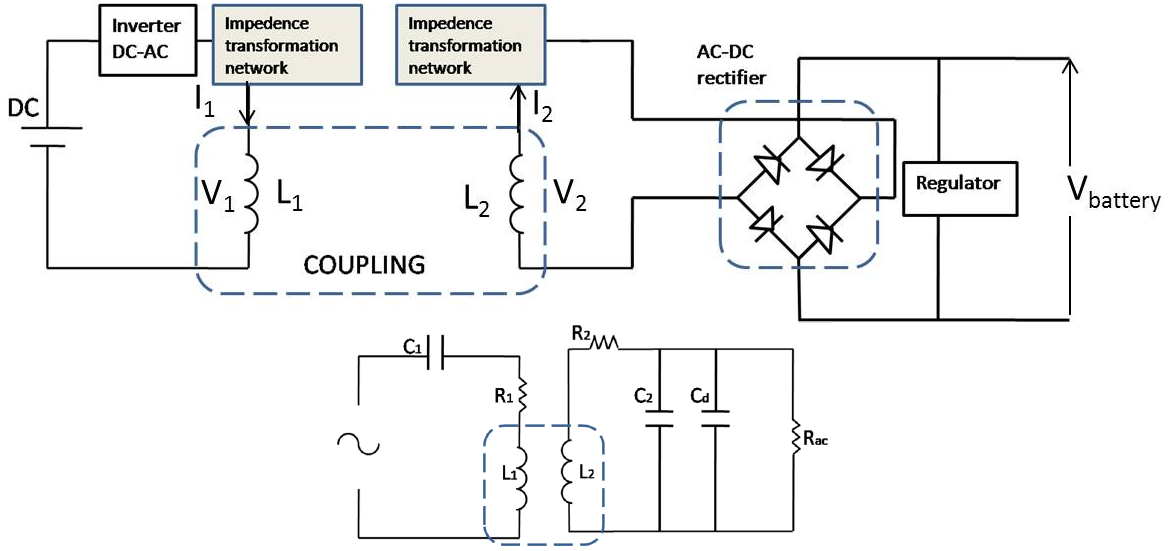
Figure 7. Top : typical series resonant coupling circuit; Bottom : AC model of typical series resonant circuit including parasitic resistances of the